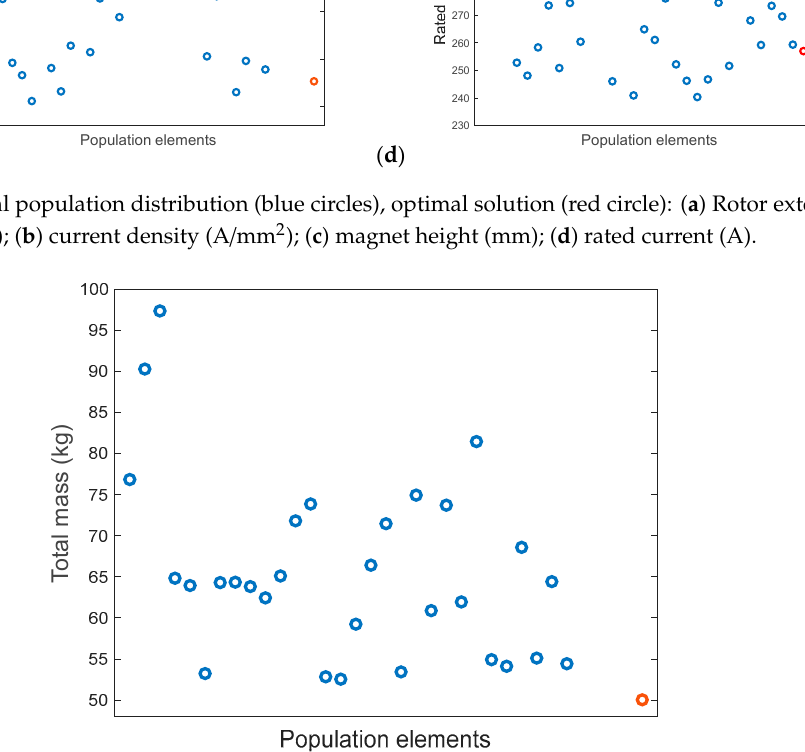
Figure 7. Objective function values: Initial population distribution (blue circles), optimal solution (red circle). Table 3. Motor obtained with the optimization.